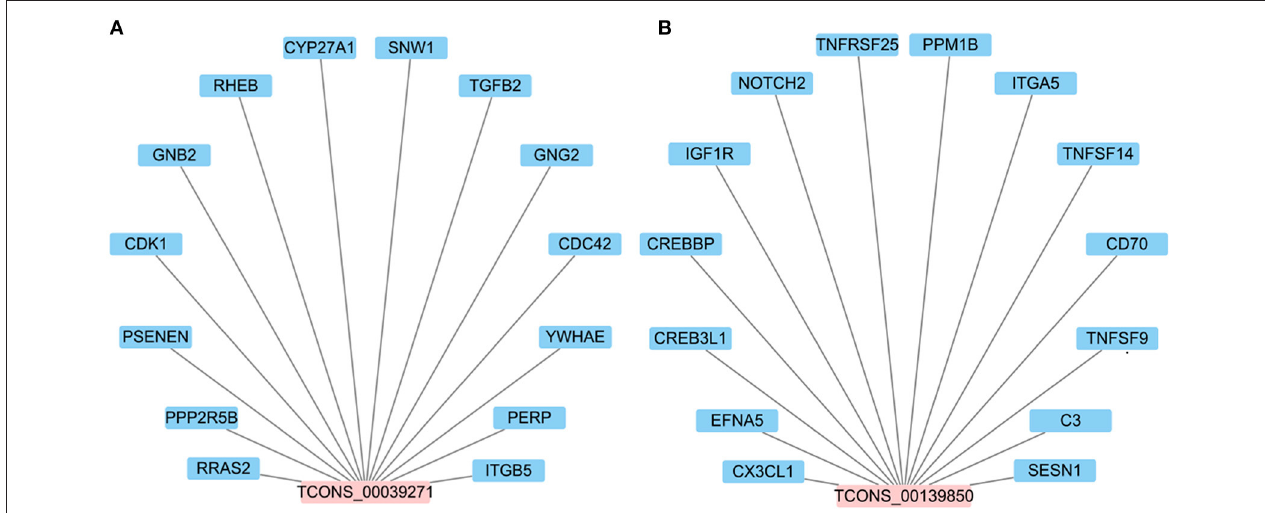
FIGURE 7 | The interaction network between candidate DElncRNAs. (A) The potential target genes of lncRNA TCONS_00039271. (B) The potential target genes of lncRNA TCONS_00139850.